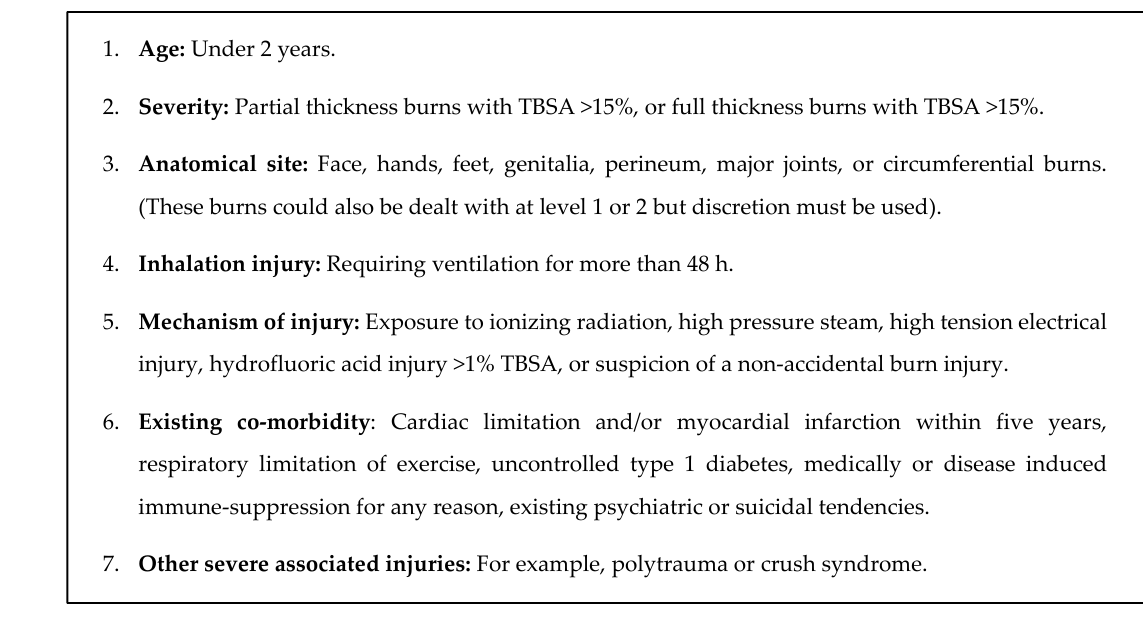
Figure 2. Western Cape provincial referral criteria for transfer to the paediatric burns centre [20].